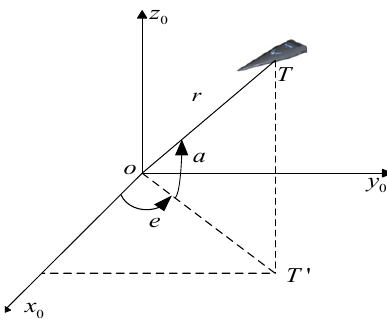
Figure 2. Target measurement in the radar observation coordinate system. The origin O is the radar coordinate, the azimuth angle is e , the elevation angle is a , and the relative distance is r .